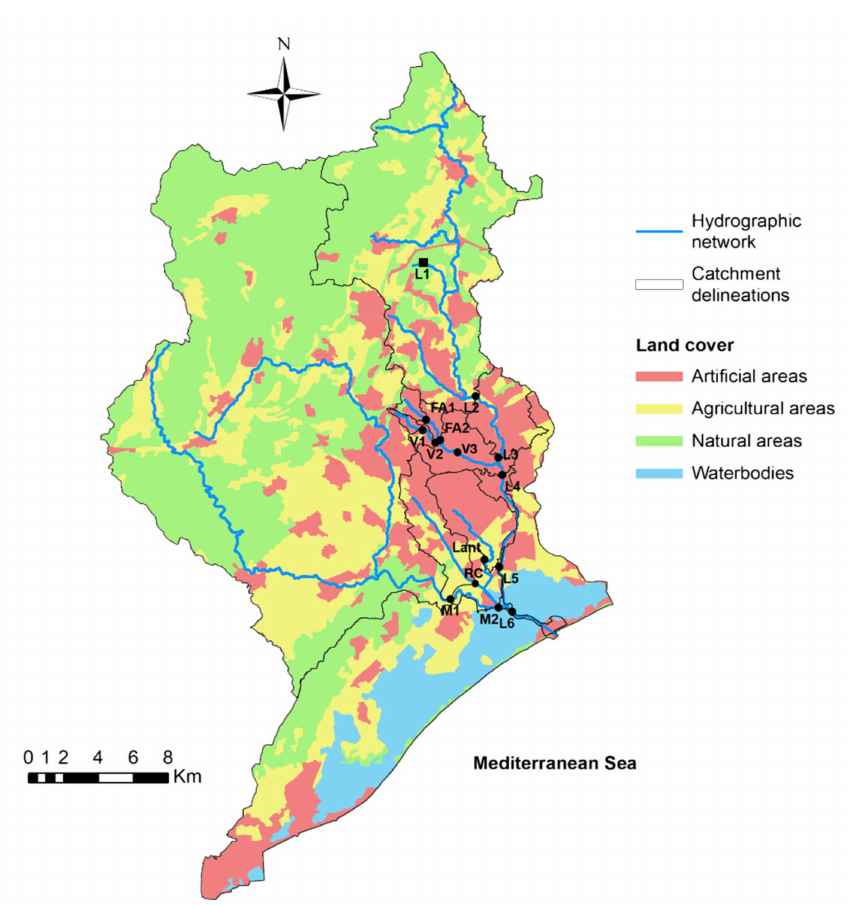
Figure 1. Watershed of the Lez river and locations of the sampling sites (L1 to L6: sampling sites on Lez River; M1 and M2: sampling sites on Mosson River; V1 to V3: sampling sites on Verdanson River; FA1 and FA2: sampling sites on Font d’Aurelle River; RC: sampling site on Rieu Coulon River; Lant: sampling site on Lantissargues